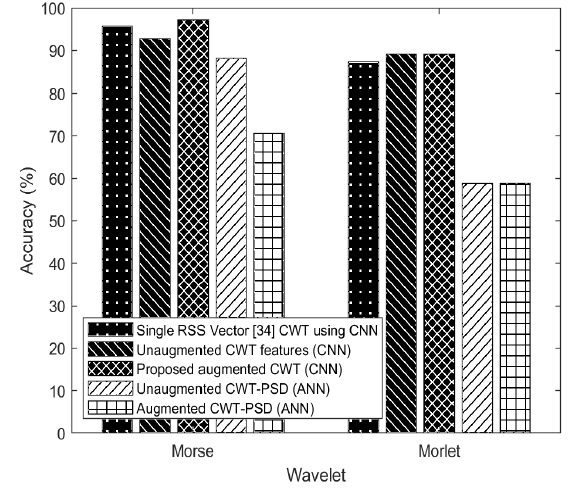
Figure 6. Accuracy results for room identification.